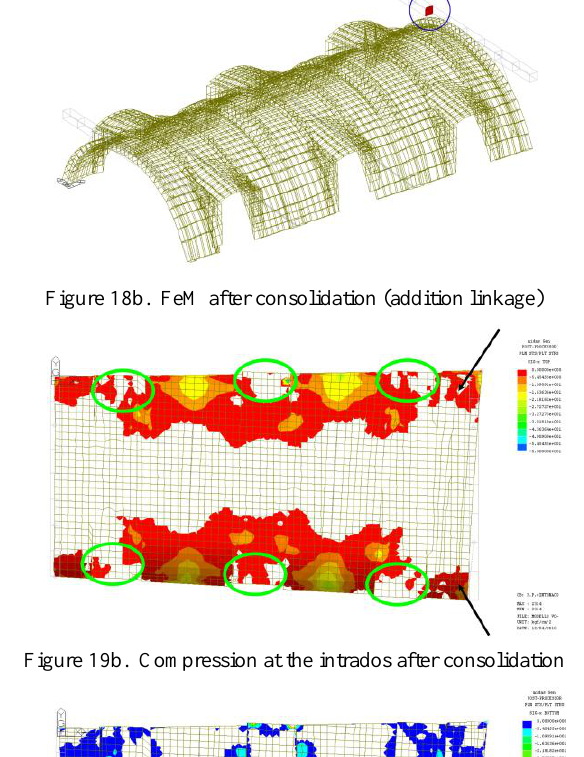
Figure 18a. FeM before consolidation (absence linkage)